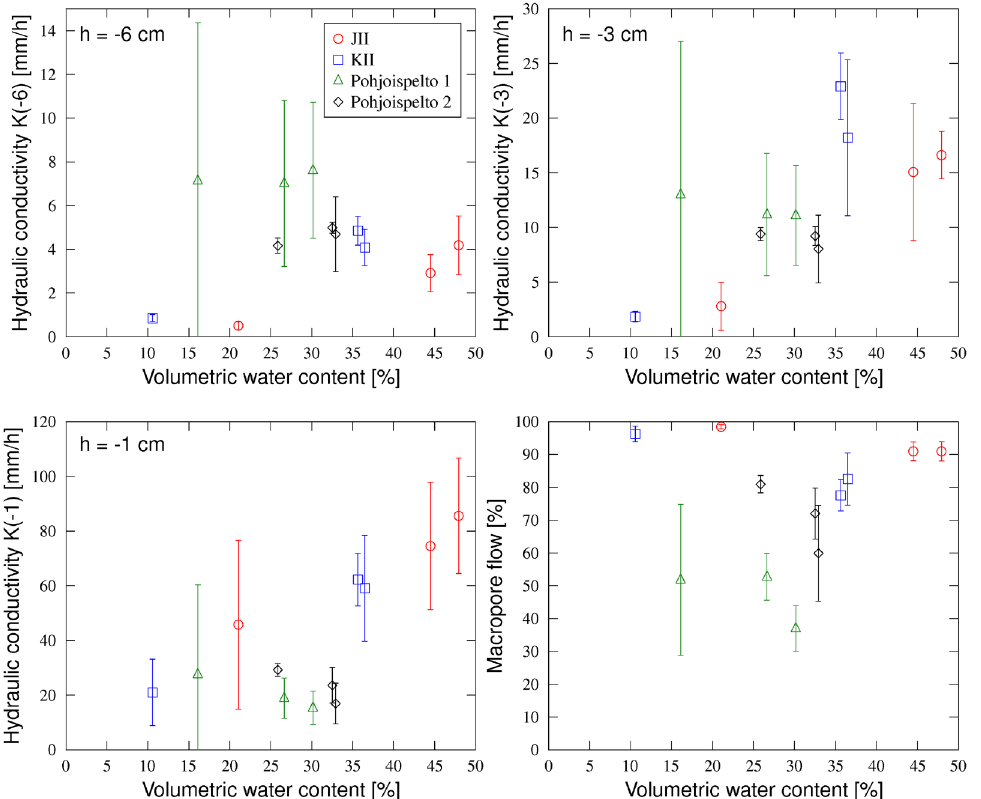
Fig. 6. Near-saturated hydraulic conductivity (K(h)) in fine-textured (JII and KII) and coarser-textured (Pohjoispelto 1 and 2) plots at different supply pressure heads (h; −6, −3, −1 cm) with progressively wetter antecedent soil moisture conditions and estimated proportion of macropore flow. The values are averages of four replicate measurements ± standard deviation. burrows form macropores, the effects of which on soil near-saturated K(h) were observed in the no-till plot in Kotkanoja leaching field. The supply pressure head used was −4, −3, −2, and −1 cm, which according to capillary the - ory excludes pores of equivalent pore diameter greater than 0.7, 1.0, 1.5, and 2.9 mm, respectively, from the infiltra - tion process. No statistically significant differences were observed for the three lowest supply pressure heads (Fig. 7).